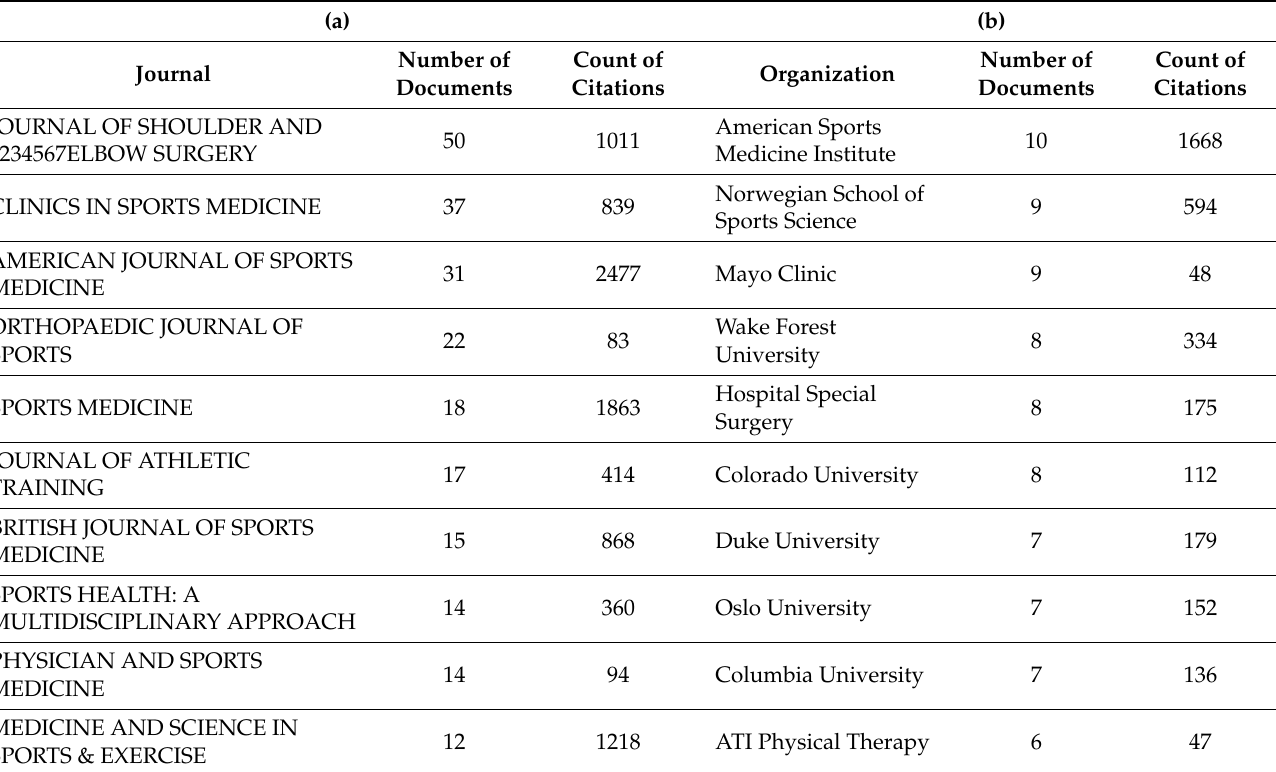
Table 1. ( a ) Top 10 journals of ‘elbow pain’ publications. ( b ) Top 10 organizations of ‘elbow pain‘ publications. ( c ) Top 10 authors of ‘elbow pain’ publications. ( d ) Top 10 countries of ‘elbow pain’